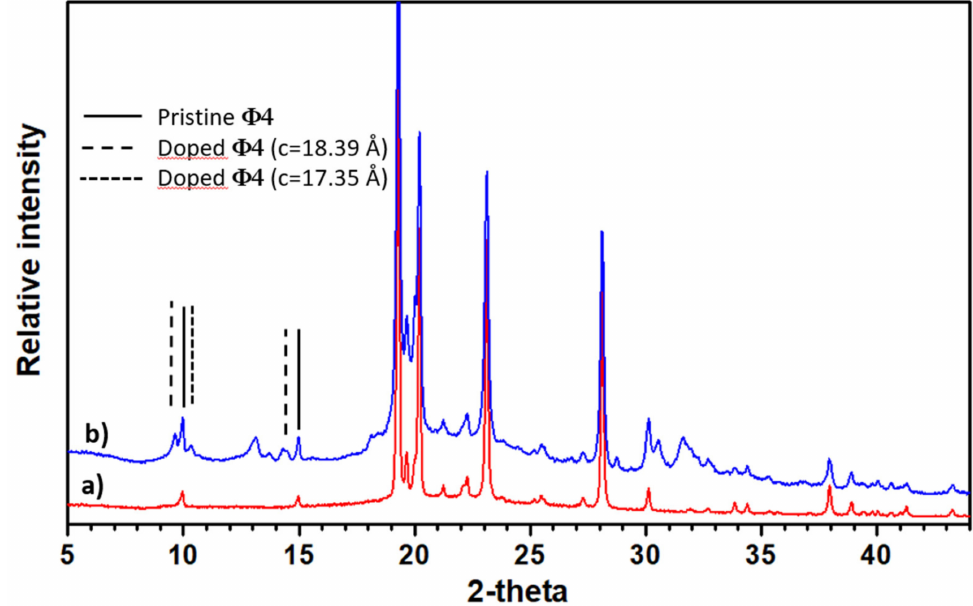
Figure 3. The φ 4-K pattern (spectrum a ) compared with the pristine material (spectrum b ). The (00l) lines are indicated in the former in regard to the different c parameter values.